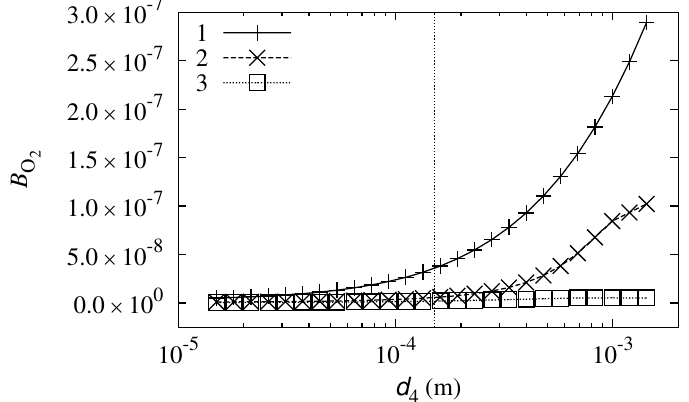
The vertical line marks